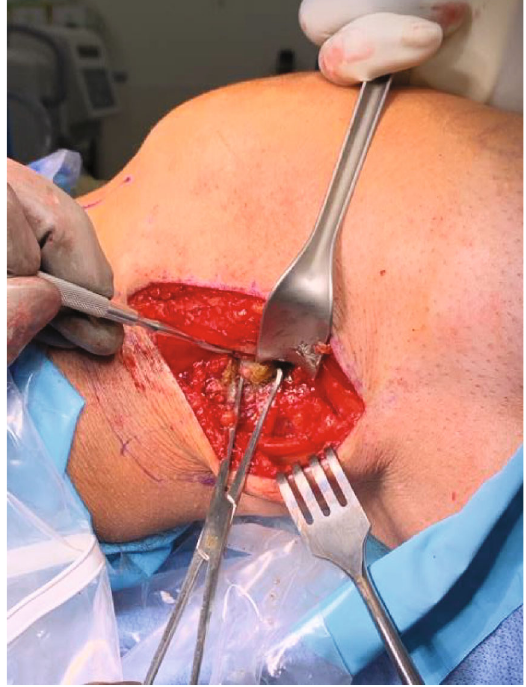
Figure 4: Fabella exposure with Allis forceps.